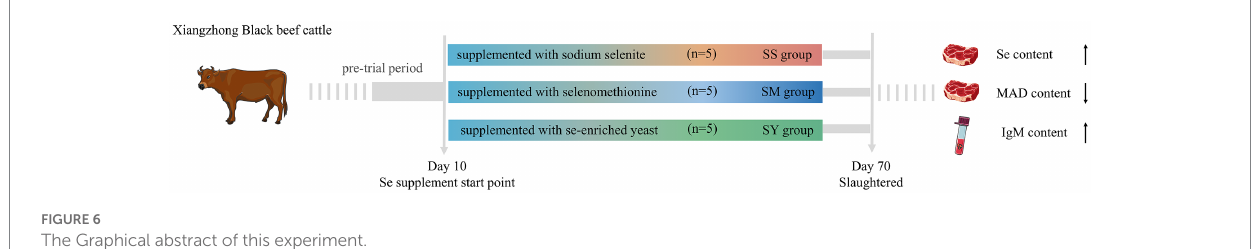
FIGURE 6 The Graphical abstract of this